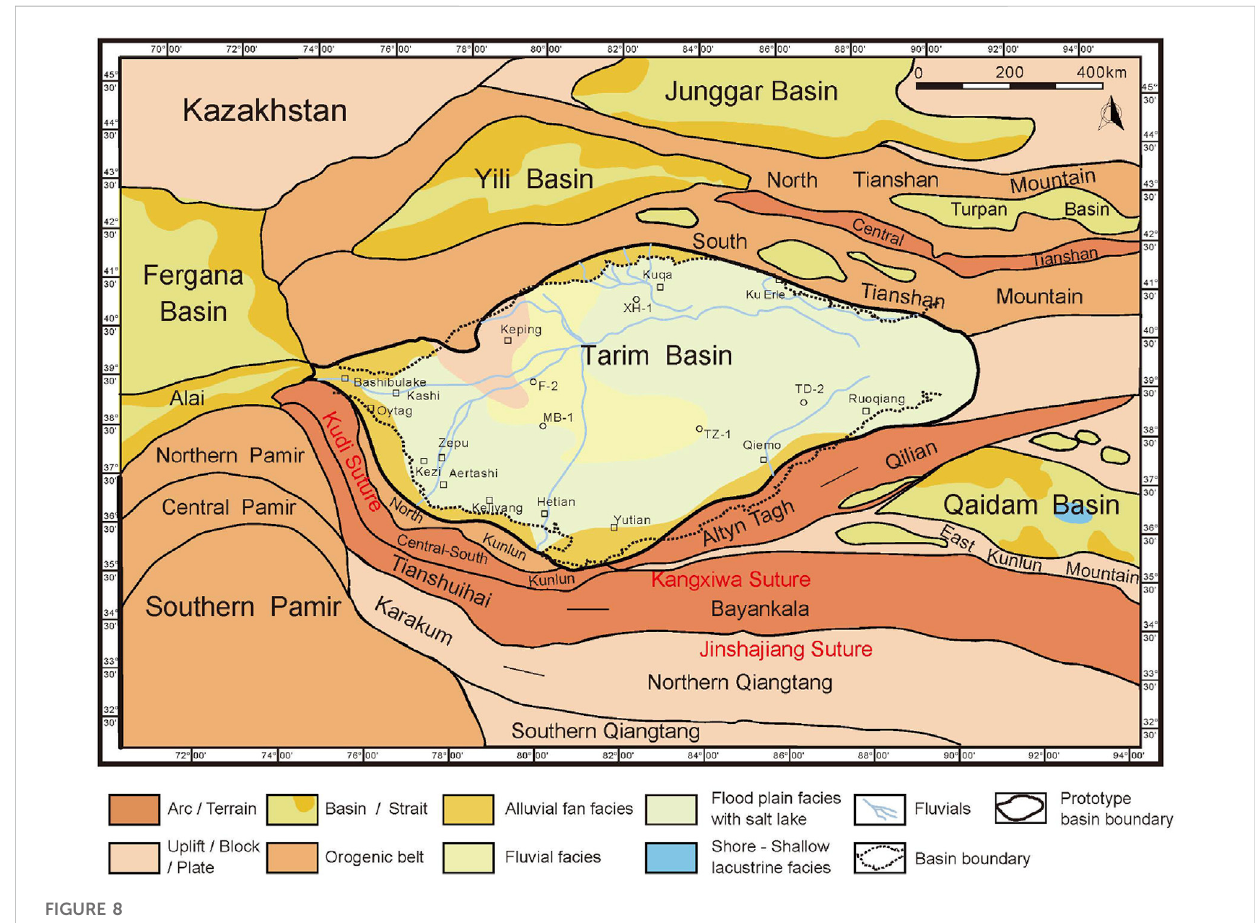
FIGURE 8 The Tarim proto-type basin and its periphery in the Late